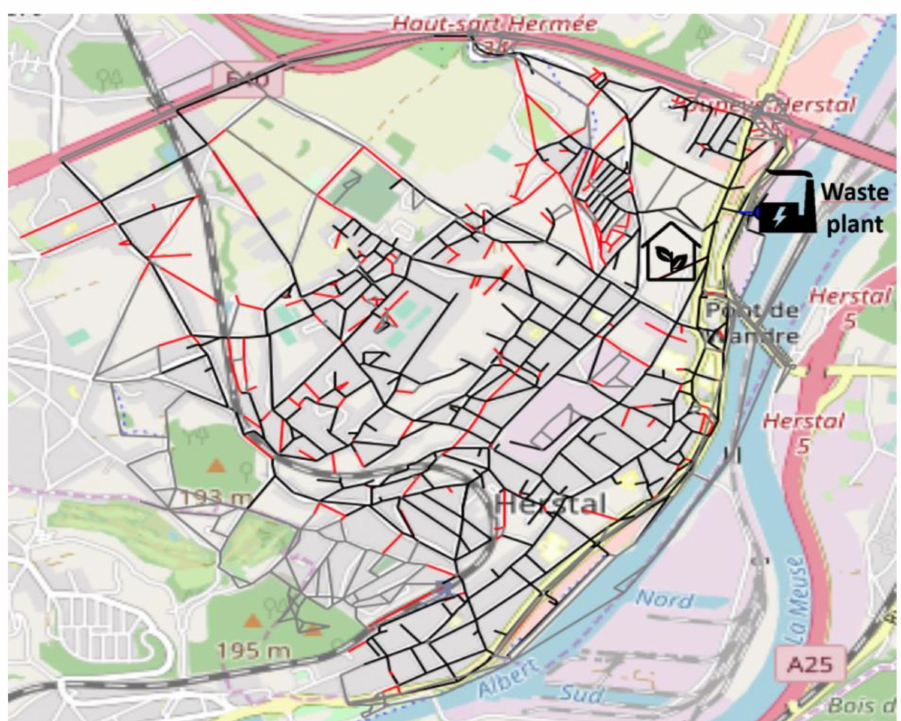
Figure 18. Optimal outline of the Herstal heating network.